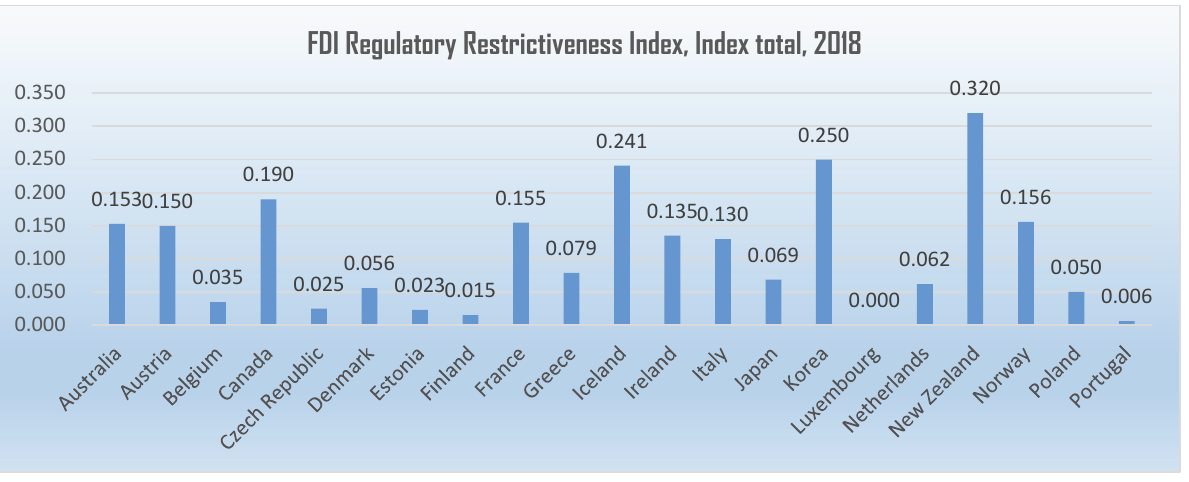
Fig.1. Total FDI index